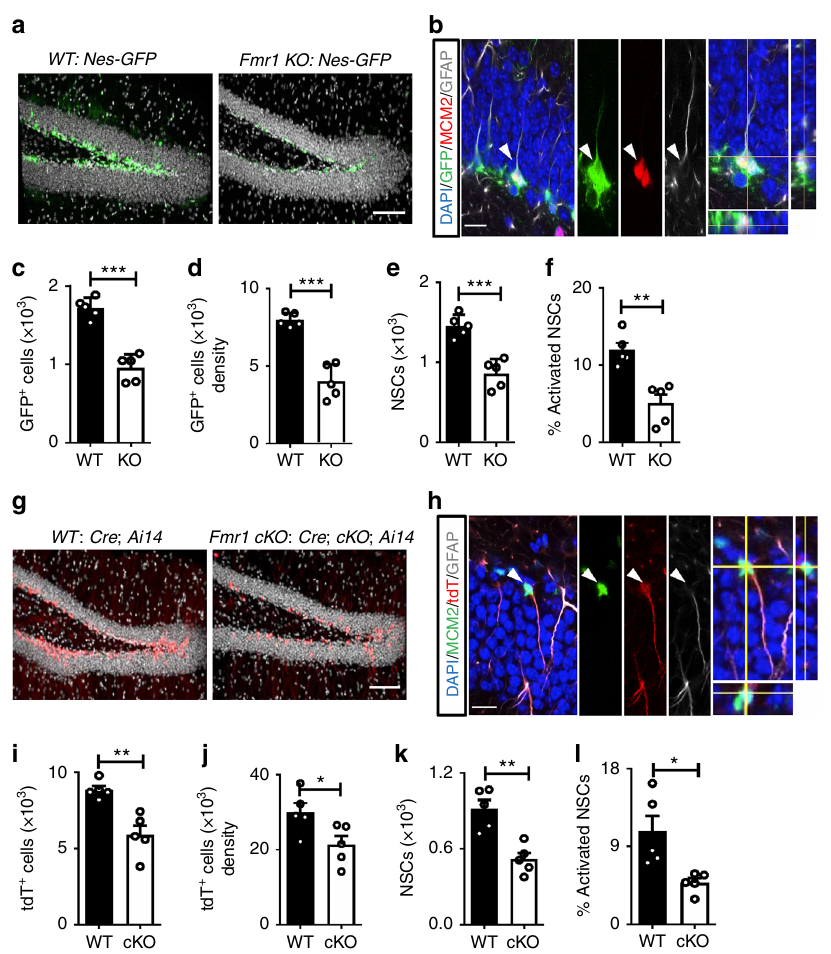
Fig. 1 FMRP de fi ciency leads to hippocampal NSC depletion in mature adult mice. a Sample confocal images of brain sections from 6-month-old WT;Nes- GFP and Fmr1 KO;Nes-GFP mice. Gray, DAPI (4 ’ ,6-diamidine-2-phenylindole dihydrochloride); green, GFP. Scale bar, 100 µ m. b Sample confocal images used for identifying NSCs (GFP + GFAP + ) and activated NSCs (GFP + GFAP + MCM2 + ) in the DG of adult Fmr1 KO and WT mice bred onto a Nes-GFP background. Green, GFP; red, MCM2; white, GFAP. Scale bar, 20 µ m. White arrowheads, activated NSCs. c , d Quantitative comparison of the number ( c ) and the density ( d , number mm − 3 ) of GFP + cells in the DG of 6-month-old adult Fmr1 KO mice and WT littermate controls. e , f Quantitative comparisons of the number of NSCs ( e ) and percentage of activated NSCs ( f ) in the DG of Fmr1 KO mice and WT littermate controls. g Sample confocal images of brain sections from cKO;Cre;Ai14 mice and Cre;Ai14 control mice. Gray, DAPI; red, tdTomato (tdT) Scale bar, 100 µ m. h Sample confocal images used for identifying NSCs (tdT + GFAP + ) and activated NSCs (tdT + GFAP + MCM2 + ) in the DG of cKO;Cre;Ai14 mice and Cre;Ai14 control mice. Red, tdT; green, MCM2; white, GFAP. Scale bar, 20 µ m. i , j Quantitative comparison of the number ( i ) and the density ( j , number mm − 3 ) of tdT + cells in the DG of 6- month-old adult cKO;Cre;Ai14 mice and Cre;Ai14 control mice. k , l Quantitative comparisons of the number of NSCs ( k ) and percentage of activated NSCs ( l ) in the DG of cKO;Cre;Ai14 mice and Cre;Ai14 control mice. * P < 0.05, ** P < 0.01, *** P < 0.001. Student ’ s t -tests were used for data analyses. Data are presented as mean ± (Supplementary Fig. 3g, h) or in NPCs isolated from the DG of 2-mo Fmr1 KO mice (Supplementary Fig. 3i, j). We therefore fi rst investigated whether upregulation of EP300 contributes to NPC impairment speci fi c to 6-mo NPCs.